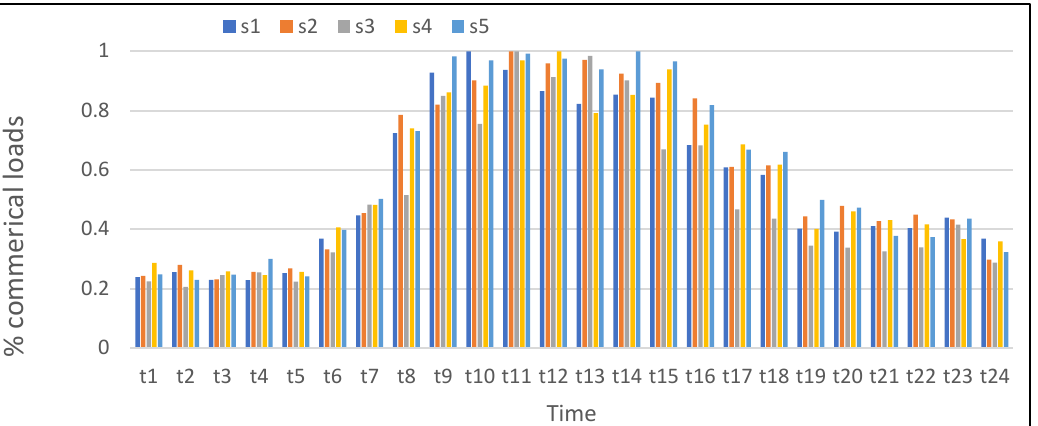
Figure 7. Daily demand profiles for commercial loads.